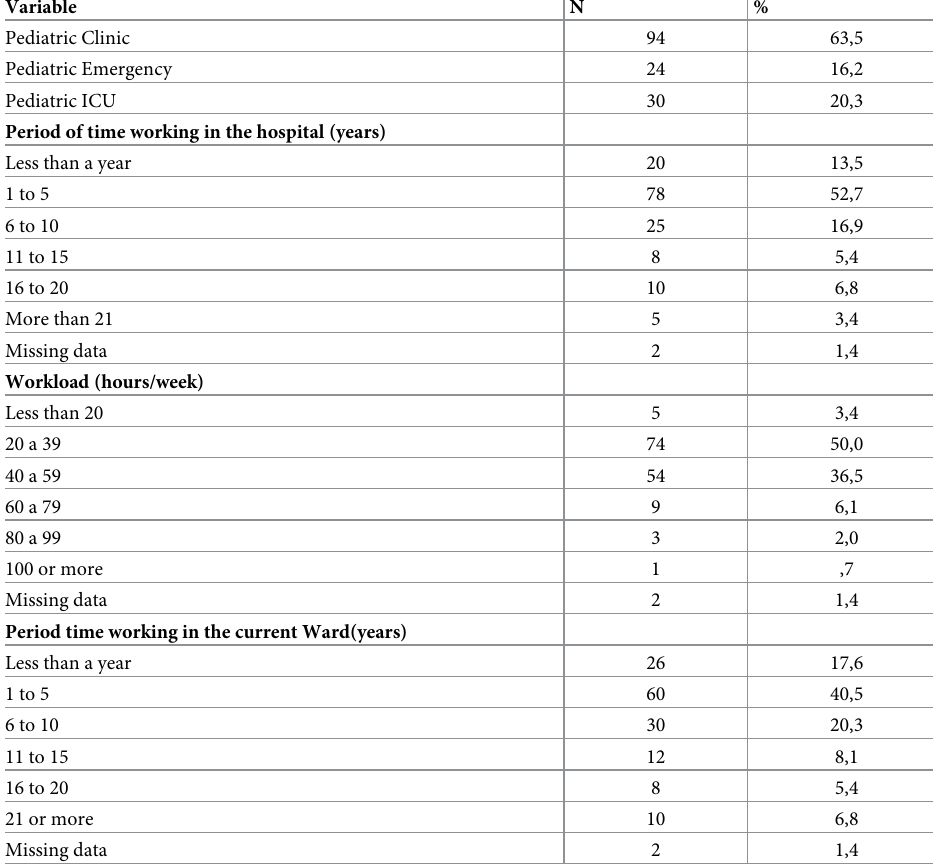
Table 2. Characterization of the sample in relation to the ward and working time period. Ceara´, Brazil, 2018. Variable N % Pediatric